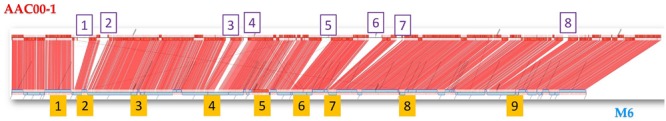
Synteny between the genomes of Acidovorax citrulli strains M6 (bottom) and AAC00-1 (top) using CONTIGuator (Galardini et al., 2011). The eight boxes at the (top) represent the 8 AAC00-1 DNA fragments that are absent in the M6 genome (FA fragments). The nine boxes at the (bottom) represent the reference fragments (RFAs) that were used as controls for coverage analyses of various A. citrulli strains. Length and nucleotide positions of FA and RFA fragments in the AAC00-1 genome are detailed in Supplementary Table S2.